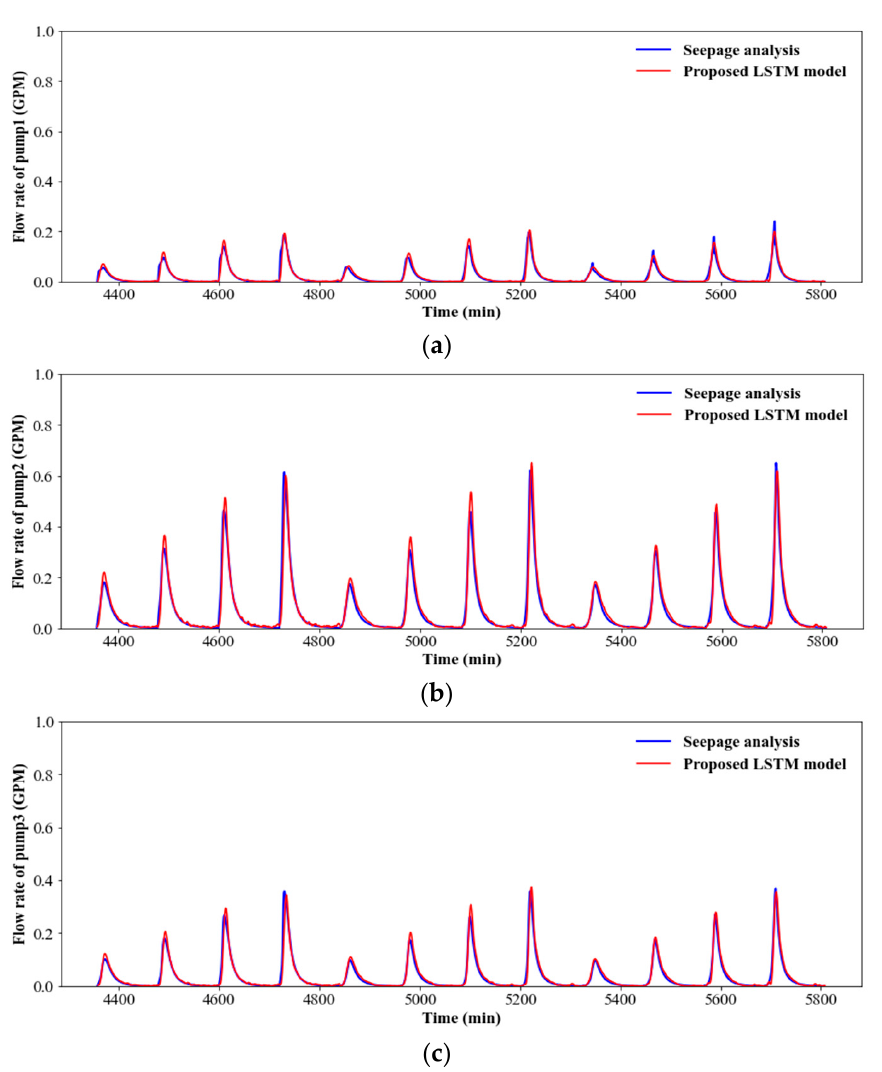
Figure 11. Comparison of pumps’ flow rate from the seepage analysis and predicted values using the LSTM model for ( a ) pump 1, ( b ) pump 2, and ( c ) pump 3. Table 5. Performance metrics of the proposed model on the testing set. Predictions RMSE (GPM) MAE